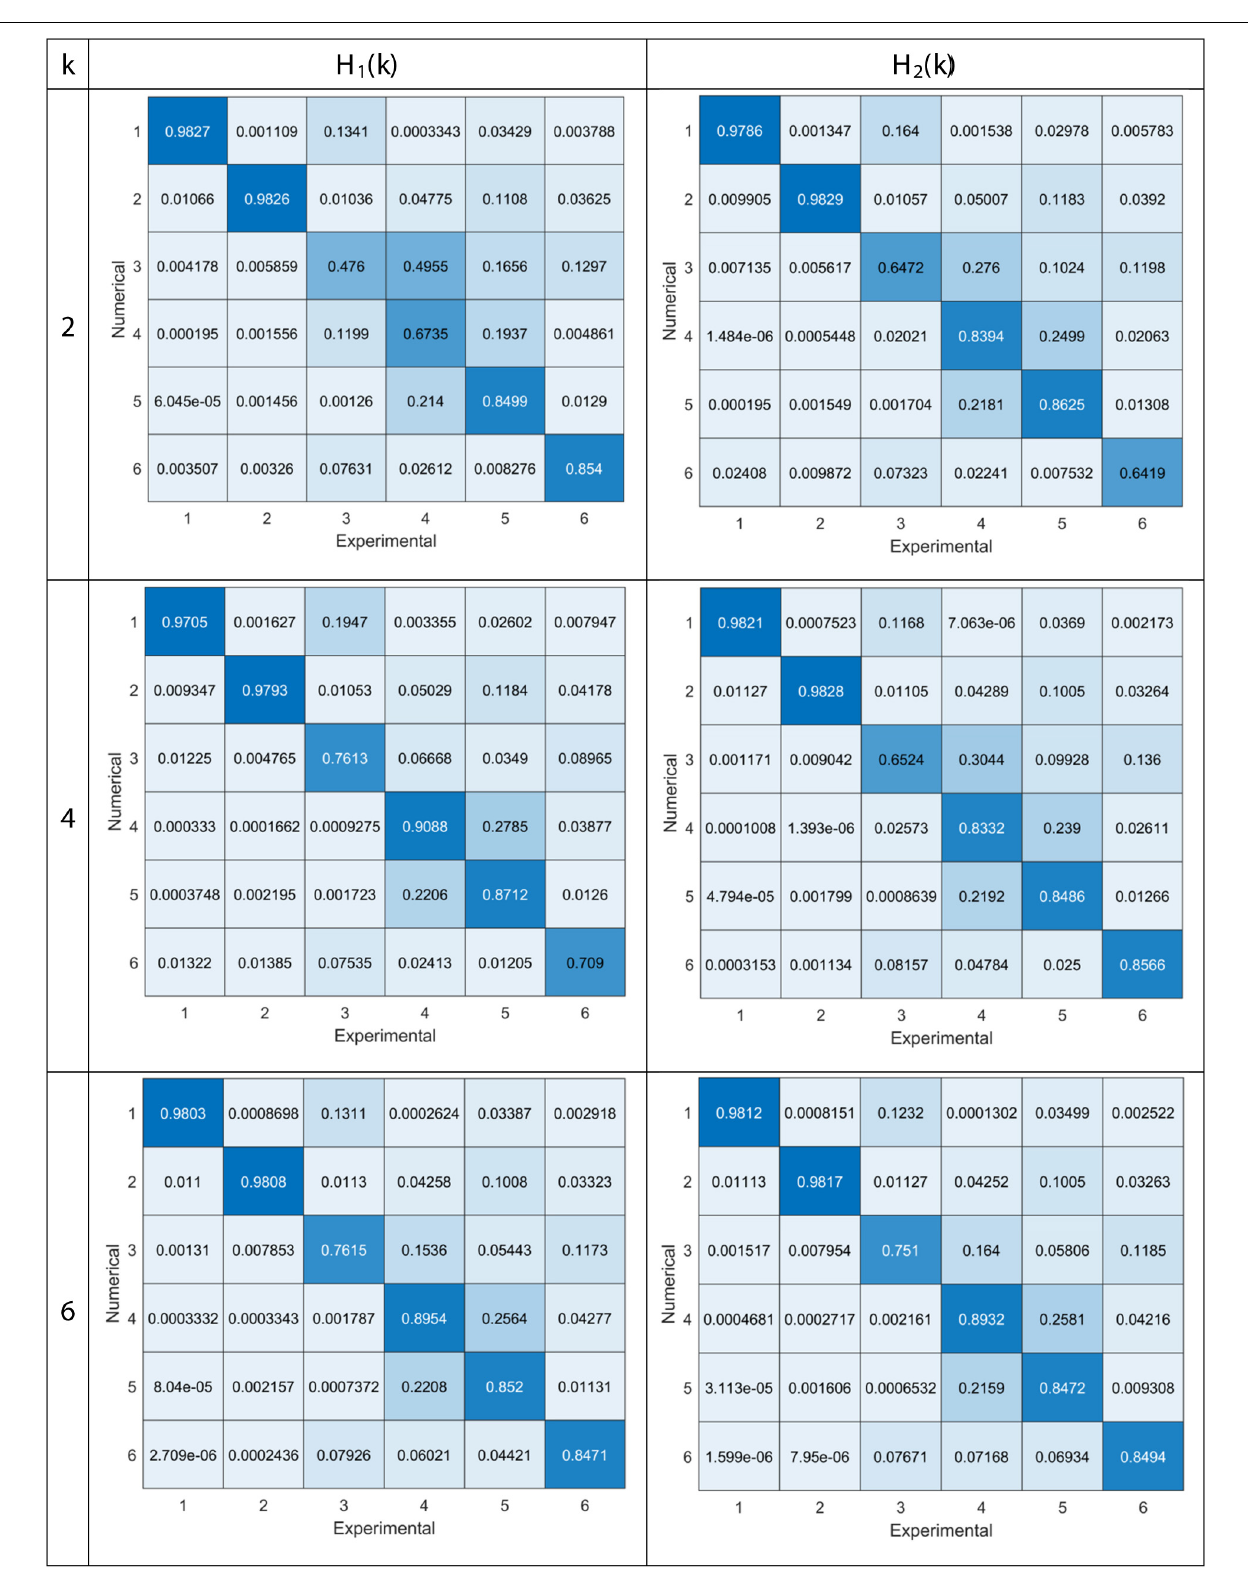
Frontiers in Built Environment |